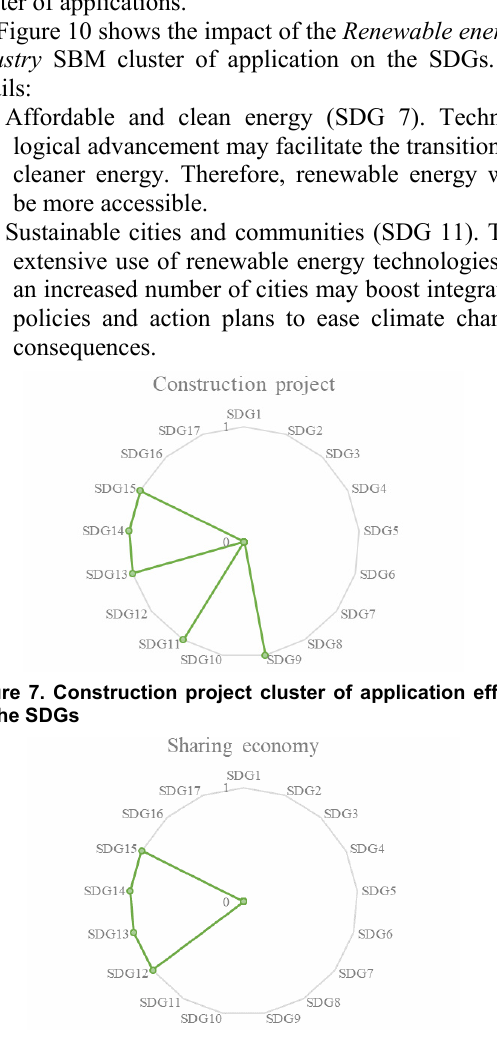
Figure 8. Sharing economy cluester of application effect on the SDGs